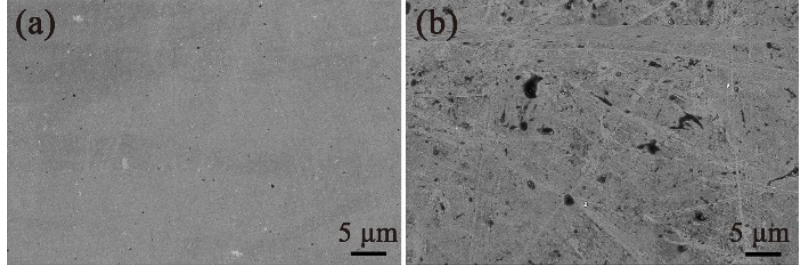
Figure 5. SEM images of the alloy surface ( a ) before and ( b ) after electrochemical corrosion.